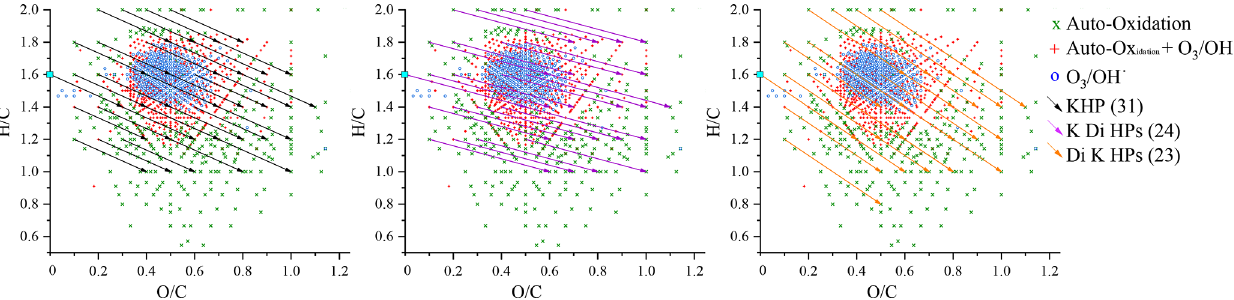
Figure 9. Representation in the van Krevelen diagram of the vectors associated with reaction mechanisms for the formation of KHPs, keto-di-hydroperoxides (K Di HPs), and di-keto-hydroperoxides (Di K